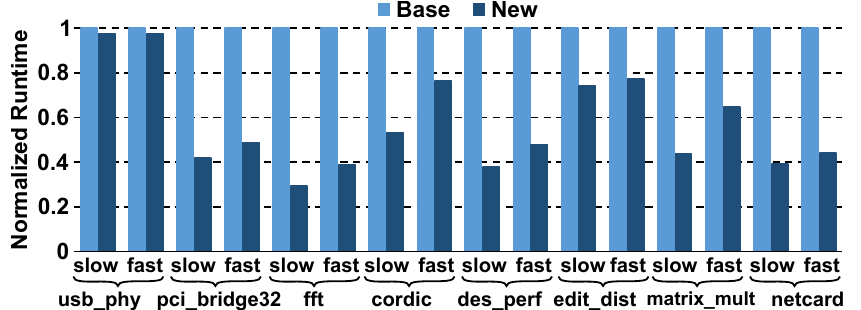
Figure 6. Runtime of both methods under comparison for all benchmarks when considering mul- tiple corners. Runtime is normalized to runtime of “Base” run. In all cases, “New” allows faster convergence saving up to 42% on average with multiple